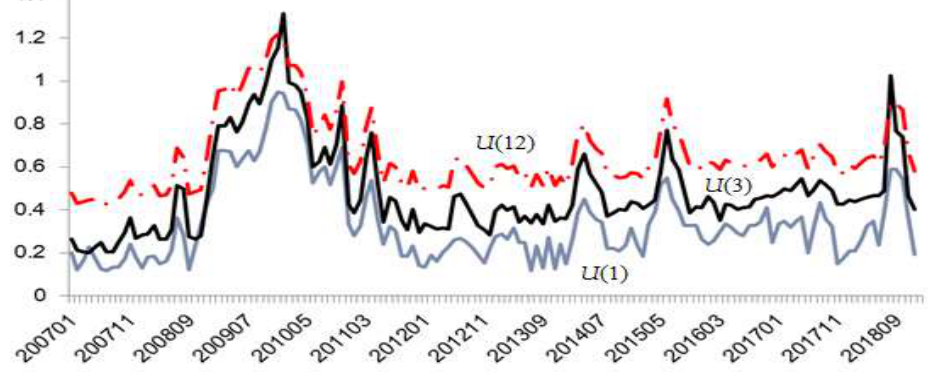
Figure 2. Explanation of variables used in constructing China’s monetary policy uncertainty index.